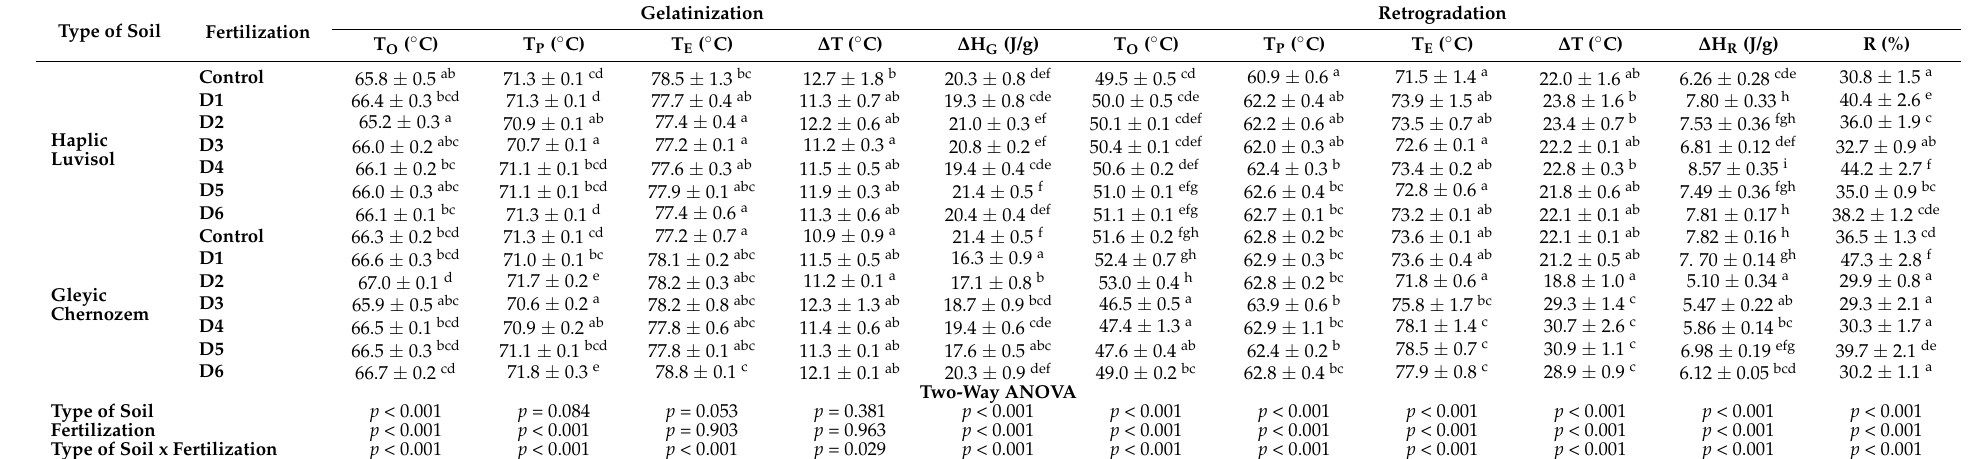
Table 3. Thermodynamic characteristics of gelatinization and retrogradation of potato